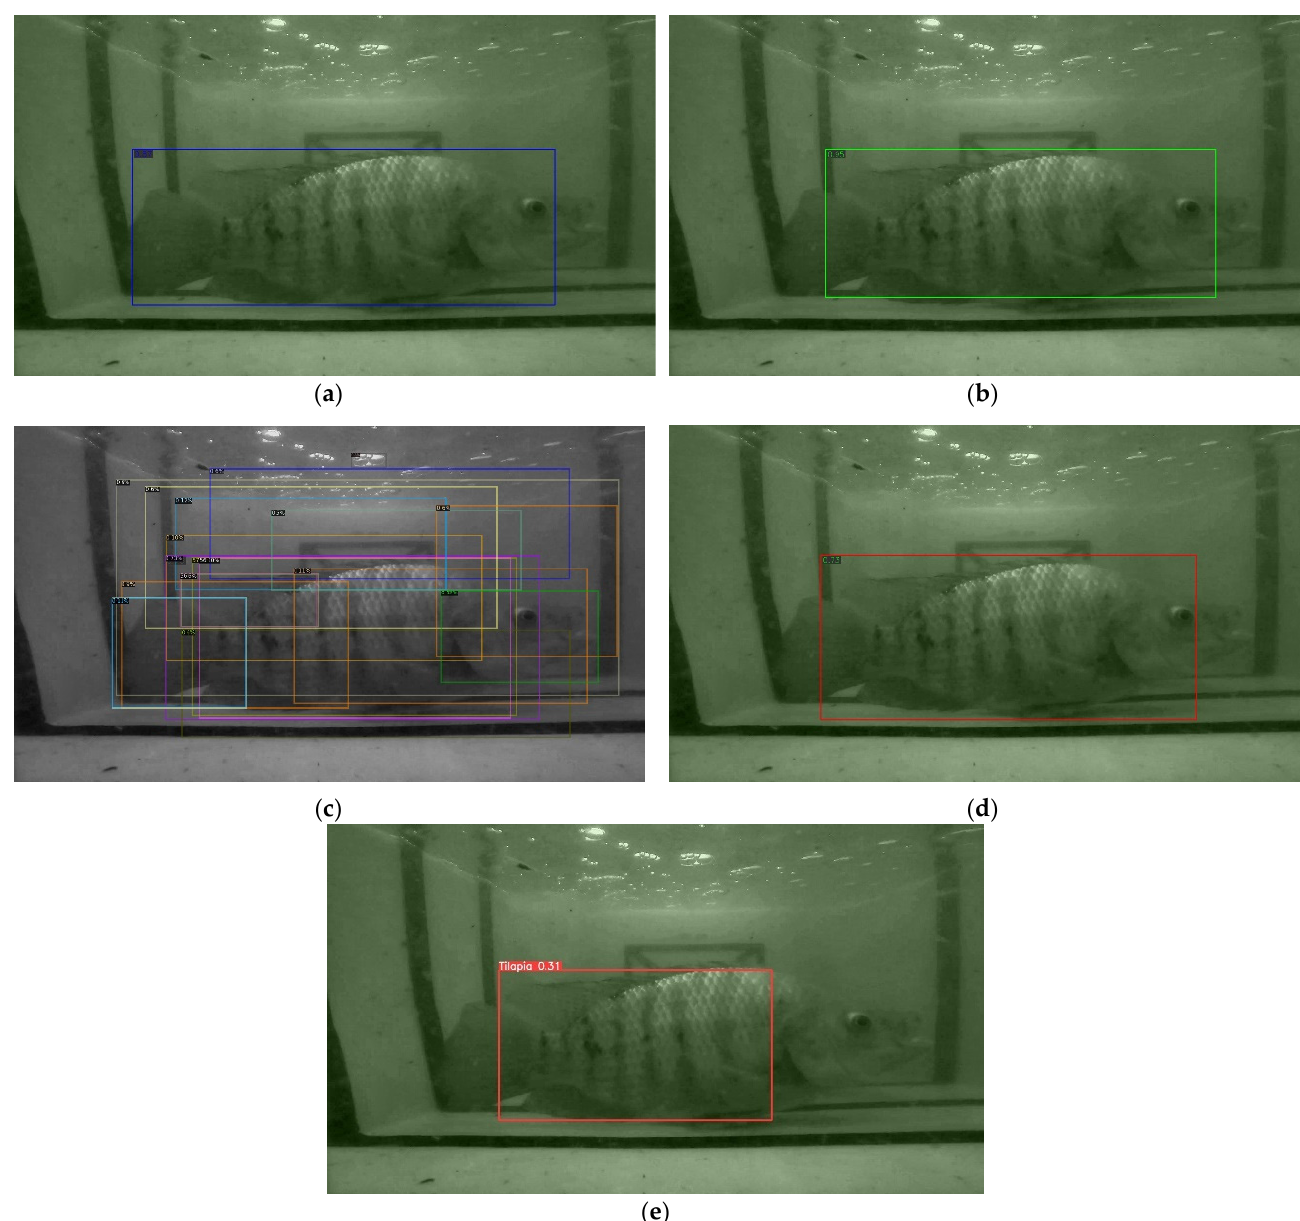
Figure 6. Sample of observed Tilapia in turbid water where ( a ) a single Tilapia; ( b ) two Tilapia with more than 50% of a body size appearance; ( c ) multiple Tilapia overlapping.